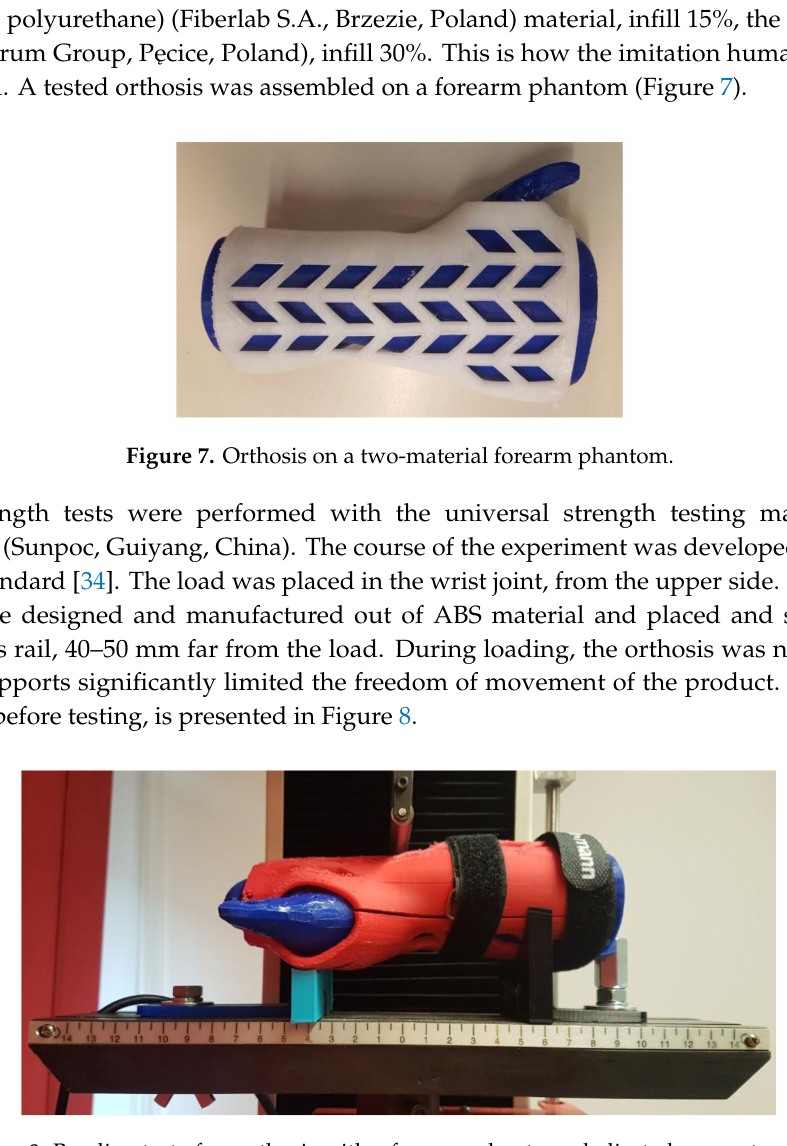
Figure 8. Bending test of an orthosis with a forearm phantom, dedicated supports